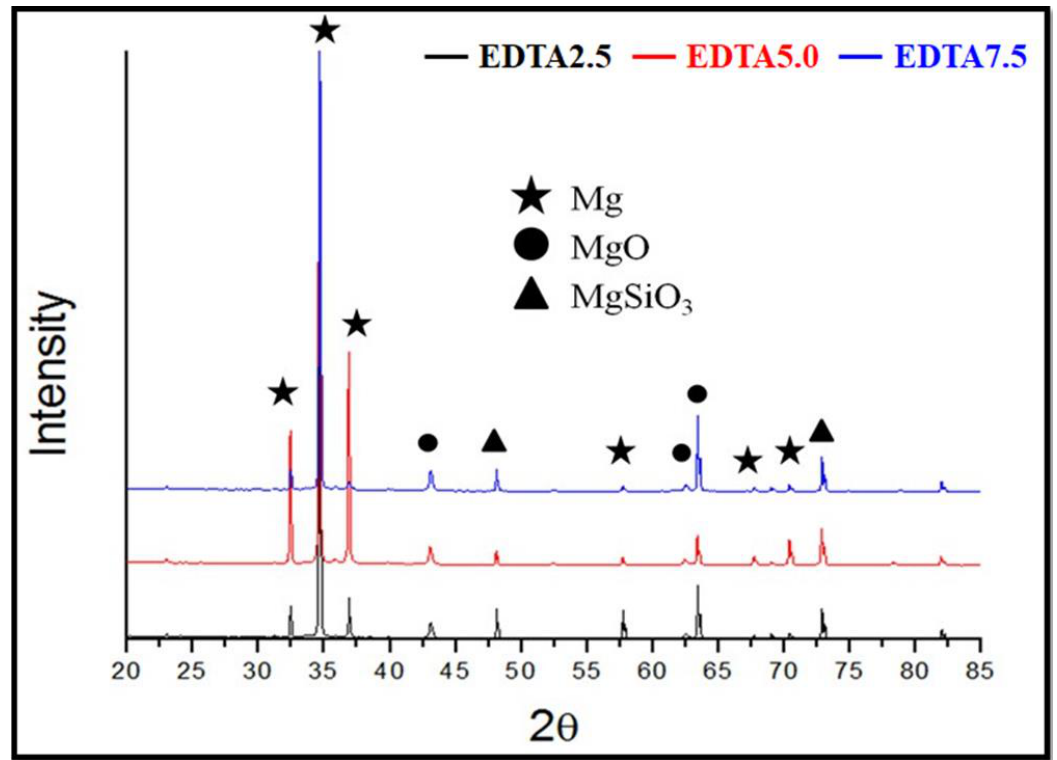
Figure 4. XRD patterns of the AZ31 sample treated in the EDTA 2.5, 5.0, and 7.5 g bath.